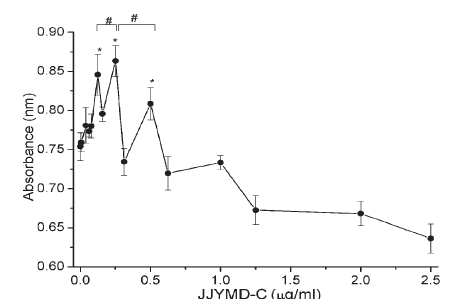
Figure 2. Cytotoxicity analysis of chondrocytes after 3 days of treatment with different concentrations of JJYMD-C. Data are reported as means±SD for n=20. *P , 0.05 compared to control; # P , 0.05 comparisons as indicated (one-way ANOVA followed by the Dunnett post hoc test).